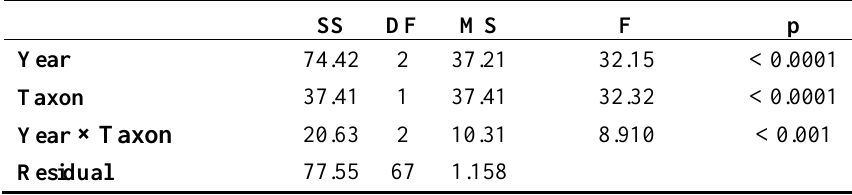
Table A1.3. Two-way ANOVA of mass standardised bite data of grazing herbivores on 1m 2 plots of EAM on the reef crest at Orpheus Island (sites pooled as no significant difference was found, data square-root transformed to meet assumptions of the test).